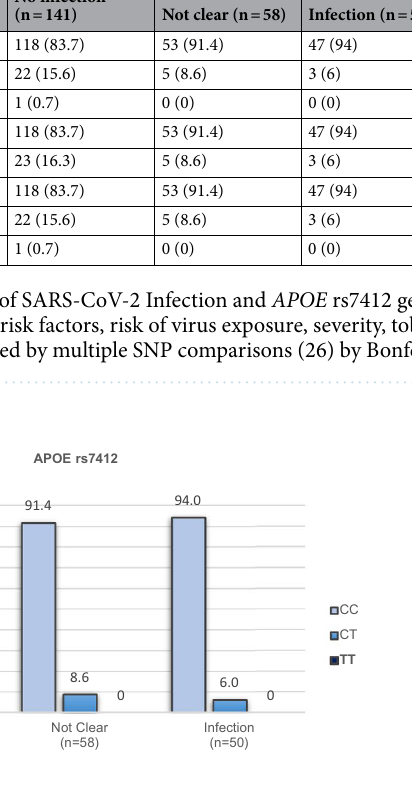
Figure 2. Percentage of the population classified according to SARS-CoV-2 infection status and the APOE rs7412 genotype in the additive model. p value = 0.039 adjusted by Bonferroni multiple